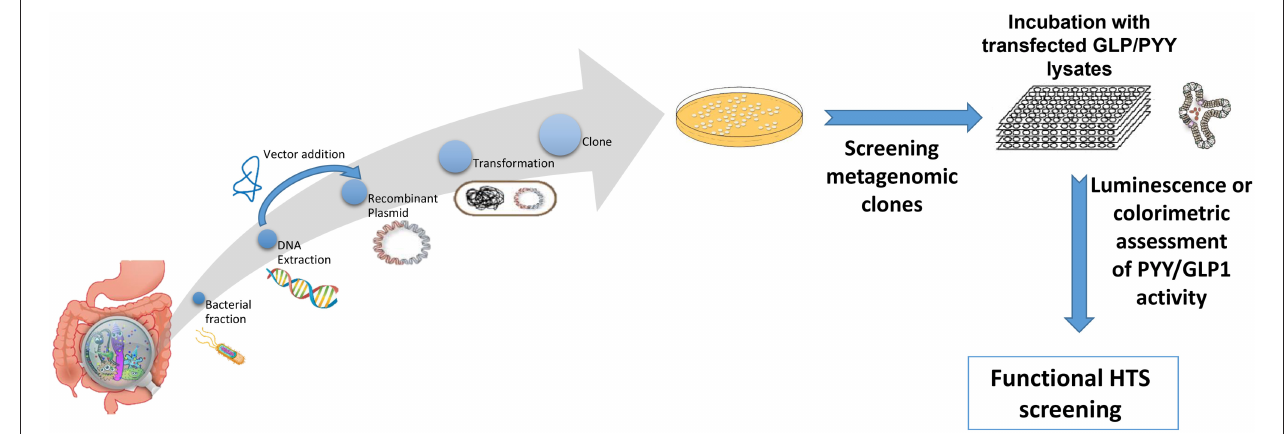
FIGURE 2 | Overview representation of functional metagenomic for screening and identification of bioactive metagenomic clones influencing expression of PYY and GLP-1 from cultured cell lines or enteroid lysates. Briefly, enteroendocrine-like cell lines (e.g., STC-1, NCI-H716) are transfected with a plasmid bearing the promoter region of PYY or GLP1 gene driving a reporter gene (e.g., luciferase; secreted alkaline phosphatase) or a genetically encoded calcium indicator, GCaMP 5G, enabling to follow Ca2 + fluxes, which directly controls peptide exocytosis. Then stably transfected cell clones are selected using selective-resistance techniques and their response characterized. The reporter cells are cultured with each candidate clone from the metagenomic library, to screen for their secretory potential of GLP-1 and PYY. Each metagenomic clone bears DNA of ∼ 40kb cloned into a fosmid. E. coli bearing empty fosmid will serve as control.